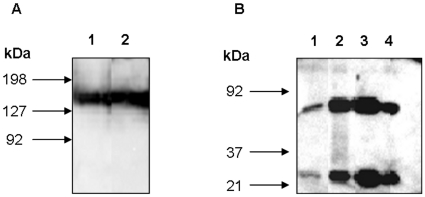
Western blot analysis of cTA12 produced in insect cells and mammalian cells.Samples of TA12 were denatured at 95°C in Laemmli buffer and electrophoresed in 13% SDS-PAGE; in non-reducing conditions (A), lane 1: cTA12 purified from ascitic fluids (clone 16G7) and lane 2: cTA12 purified from Sf9 supernatant; and in reducing conditions (B) Lane 1: Sf9 supernatant, lane 2: cTA12 purified from Sf9 supernatant, lane 3: cTA12 purified from ascitic fluids (clone 16G7), lane 4: unpurified ascitic fluids (clone 16G7). After transfer, membranes were incubated with a polyclonal rabbit anti-human antibody, detected with HRP-conjugated anti-rabbit IgG and revealed using chemiluminescence.